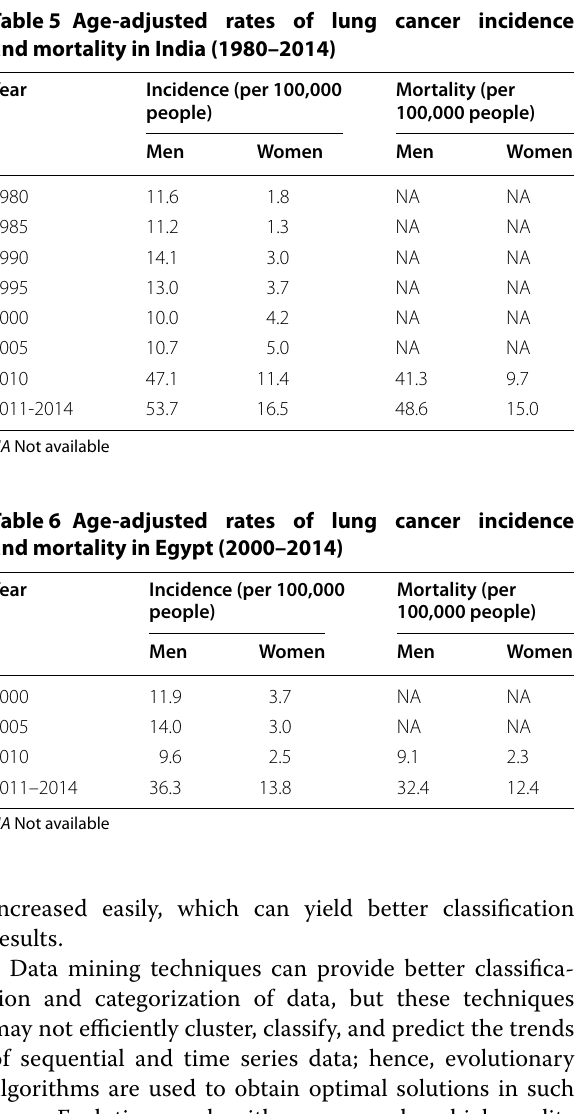
Table 5 Age-adjusted rates of lung cancer incidence and mortality in India (1980–2014)